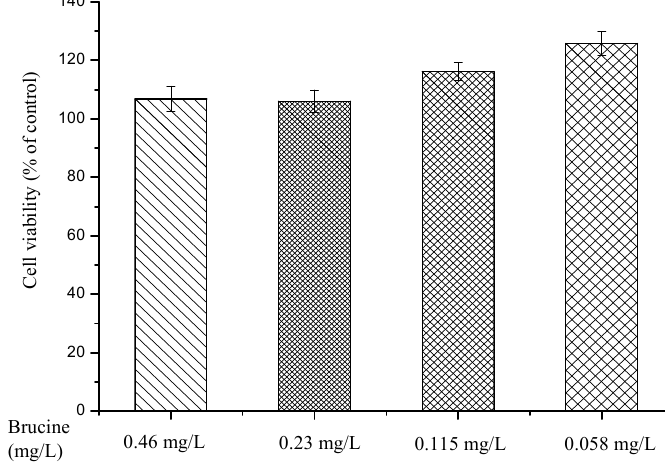
Figure 8. Cytotoxicity evaluation of brucine at different concentrations.